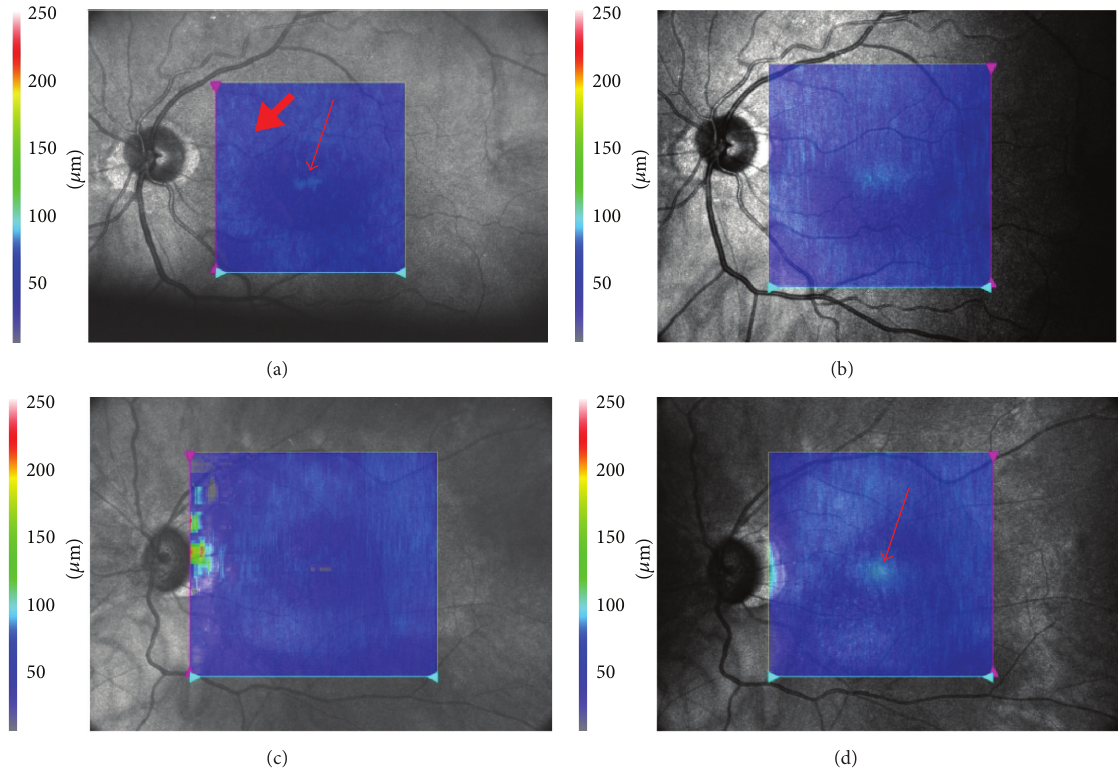
Figure 3: En face reflectivity maps at the level of the IS/OS layer. Maps were calculated for an area of 6 × 6mm. The bright blue color depicts regions of normal IS/OS reflectivity. The dark blue color indicates areas of reduced IS/OS reflectivity. (a) Patient 1. Map calculated 9 months after surgery. Areas of normal reflectivity are visible in the peripheral part of the macula (thick arrow). A small, bright island is also visible in the center of the fovea (thin arrow). (b) Patient 1. 16 months after surgery. Areas of normal reflectivity have enlarged significantly. The superior macula and the central area of normal IS/OS have merged. (c) Patient 2. Seven months after surgery. An area of normal IS/OS is visible in the peripheral part of the macula (bright blue). (d) Patient 2. 14 months after surgery. A new area of normal reflectivity has appeared in the central fovea